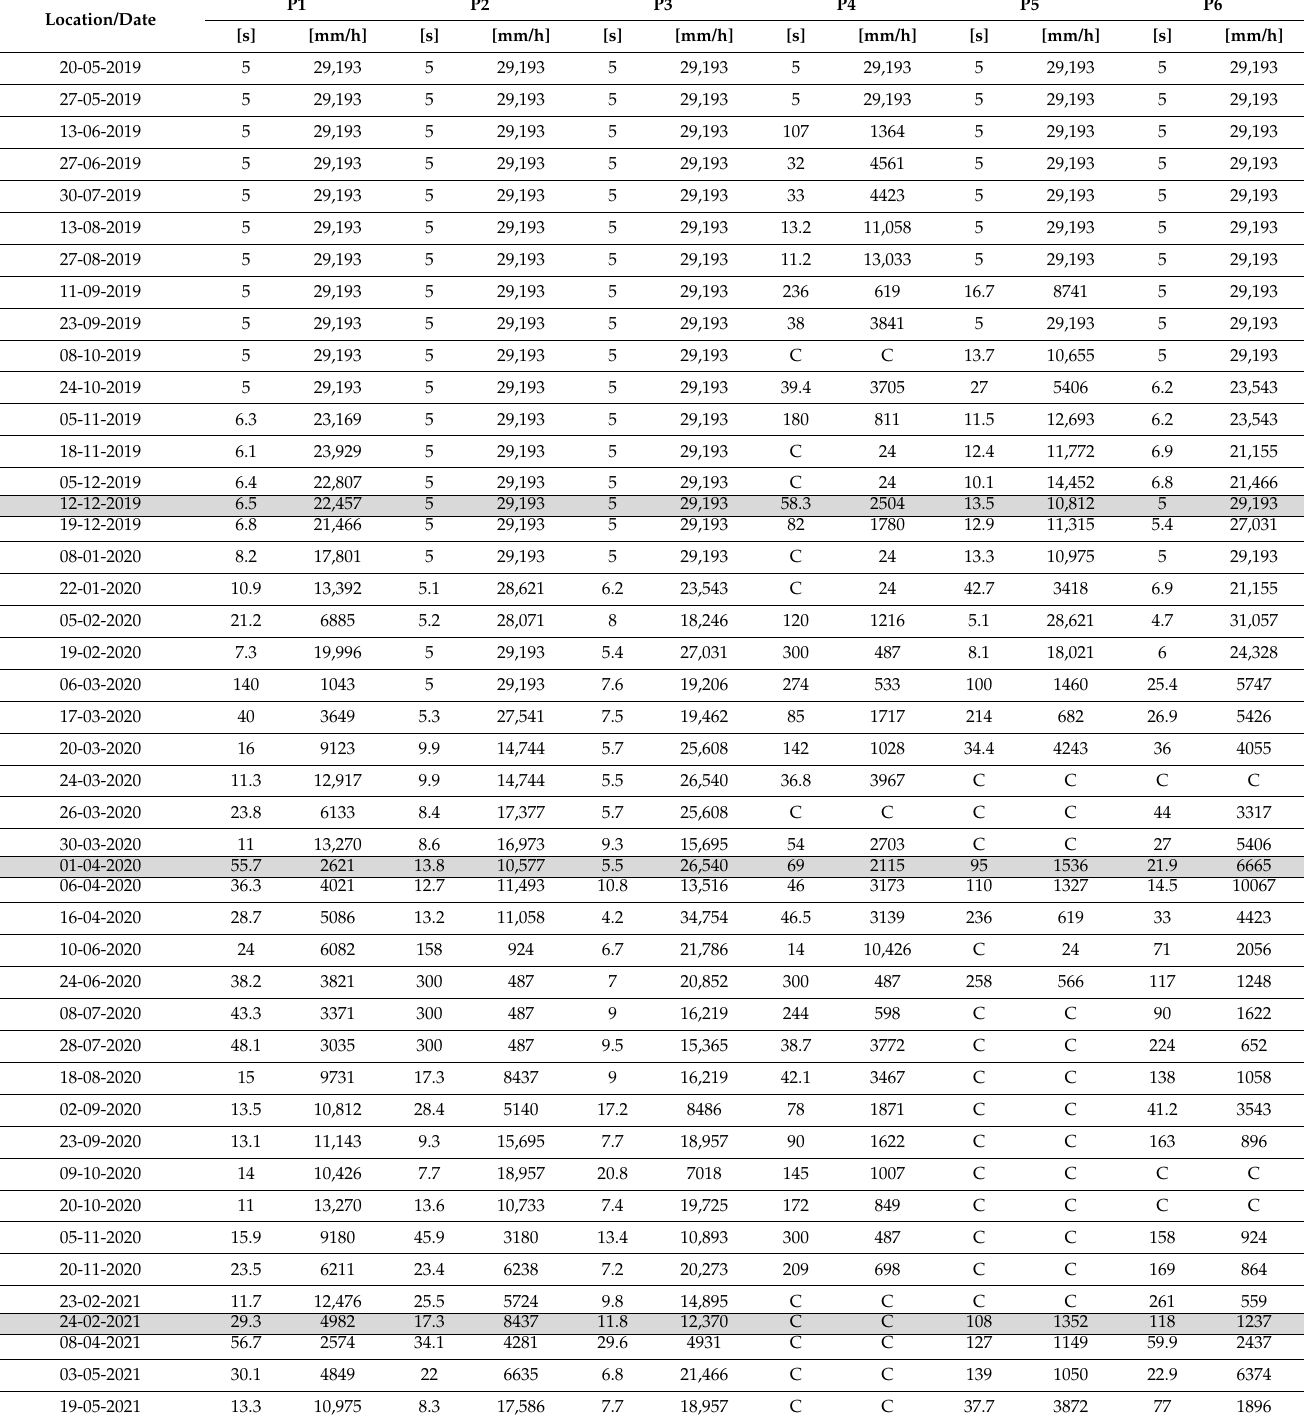
Table 1. Infiltration time and calculated infiltration capacity using Becker’s